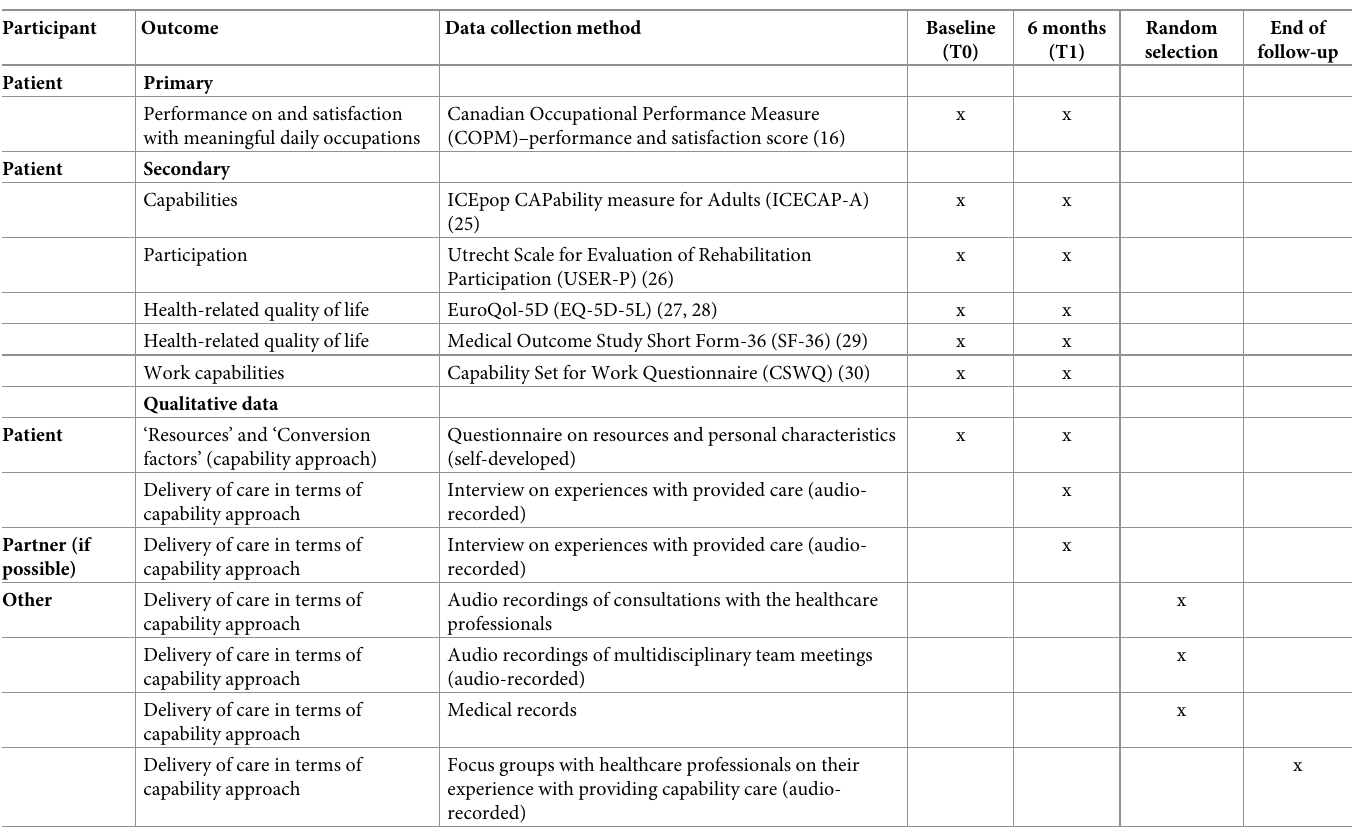
Table 2. Methods of data